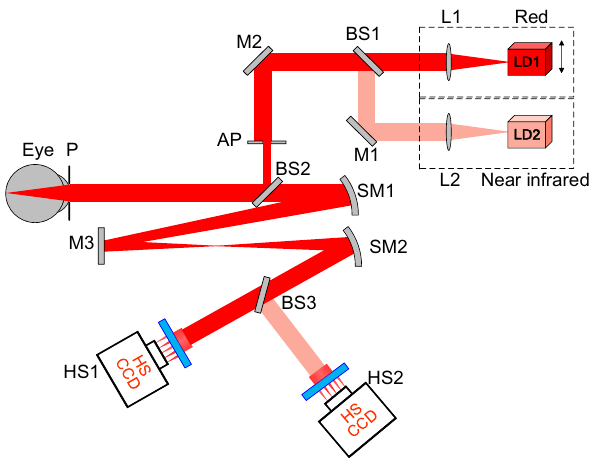
Fig. 2. Illustration of the chromatic-aberration measurement system, which comprises: L: collimating lens, P: pupil of the eye, AP: arti¯cial pupil, BS: beam splitter, SM: spherical mirror and M: plane mirror.